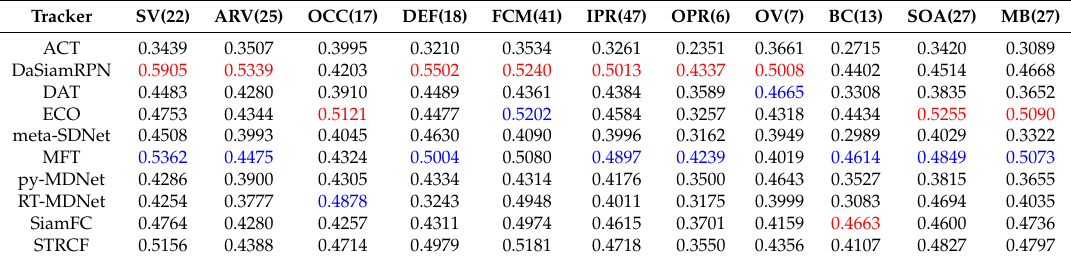
Table 6. Overlap results for various DTB70 dataset attributes listed in Table 1. Top performing tracker is shown in red and the second best performer is shown in blue. Best viewed in color. Tracker